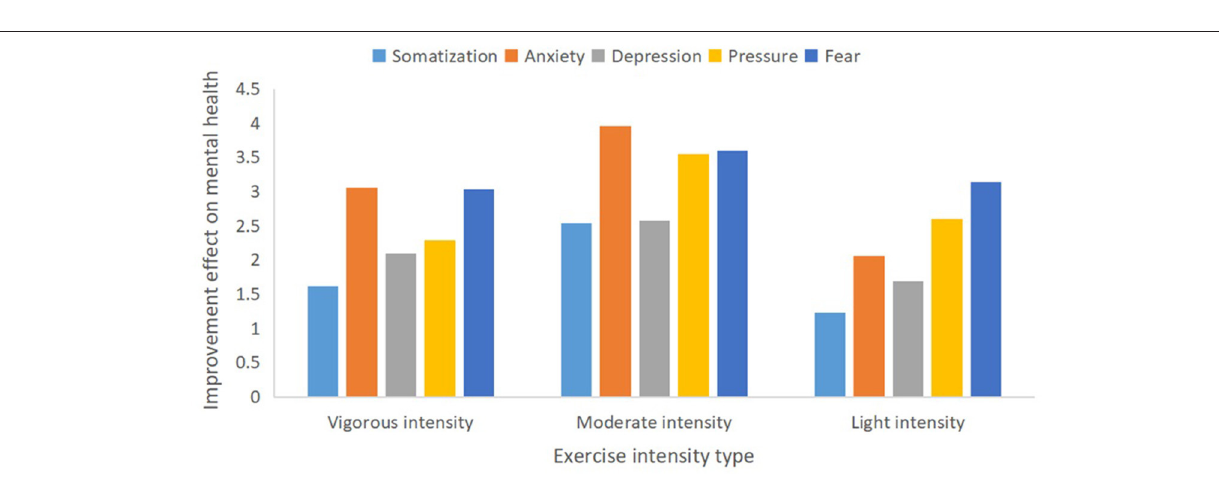
FIGURE 5 | Different physical exercise intensities and mental health